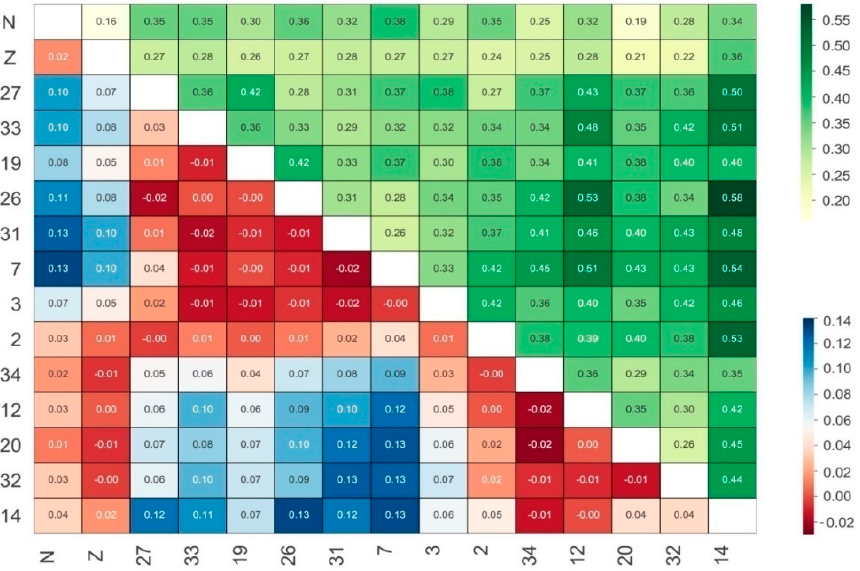
Figure 2. Pairwise Nei’s genetic distance (above diagonal) and genetic differentiation index (below diagonal) among P. trituberculatus populations. “N” and “Z” stand for crabs caught from Nantong and Zhoushan.